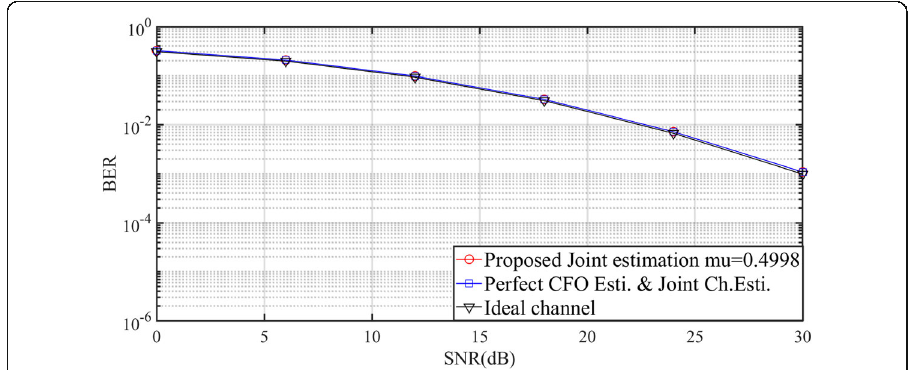
Fig. 15 The BER performance of the joint estimation in the adaptive mode at v = 60